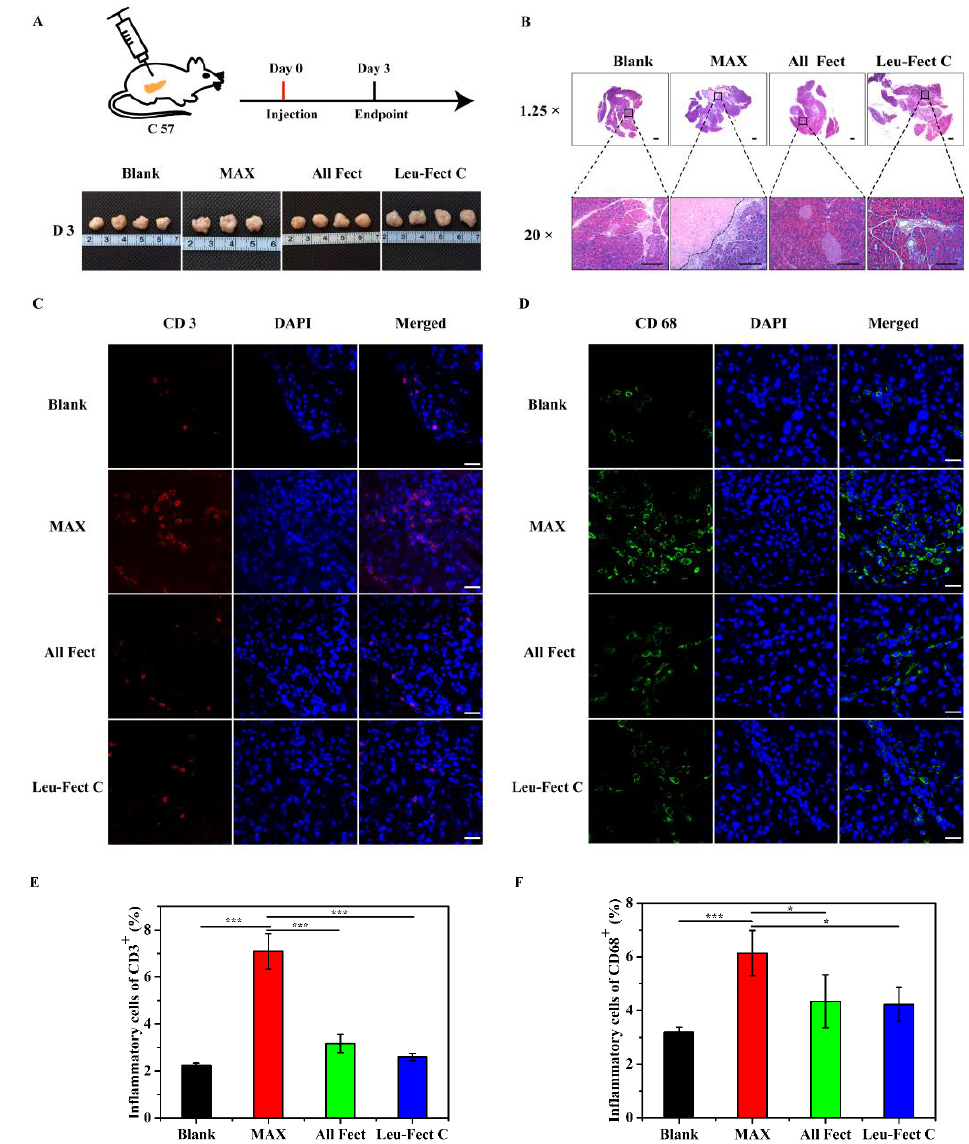
Figure 8. In vivo biocompatibility of the polymeric vectors in the pancreatic organ. ( A ) A mixture of 50 µ L vector (1 µ g/ µ L) and 50 µ L serum-free Opti-MEM medium was evenly injected into the pancreas and the organs were harvested after 3 days ( n ≥ 3 mice). The lower part of ( A ) is the gross appearance of the pancreatic organs. ( B ) Histopathological analysis of pancreatic organs. The typical tissue sections were indicated at low (upper part) and high (lower part) magnification pictures. (The scale bar is 500 and 100 µ m, respectively). ( C , E ) Sections were stained with CD3 and CD68 to detect the specific immune cells in the pancreatic organs. ( D , F ) Quantitative analysis of CD3 + and CD68 + cells in the tissue sections, respectively. (Scale bar is 25 µ m for ( C , D ). * p < 0.05, *** p < 0.001).